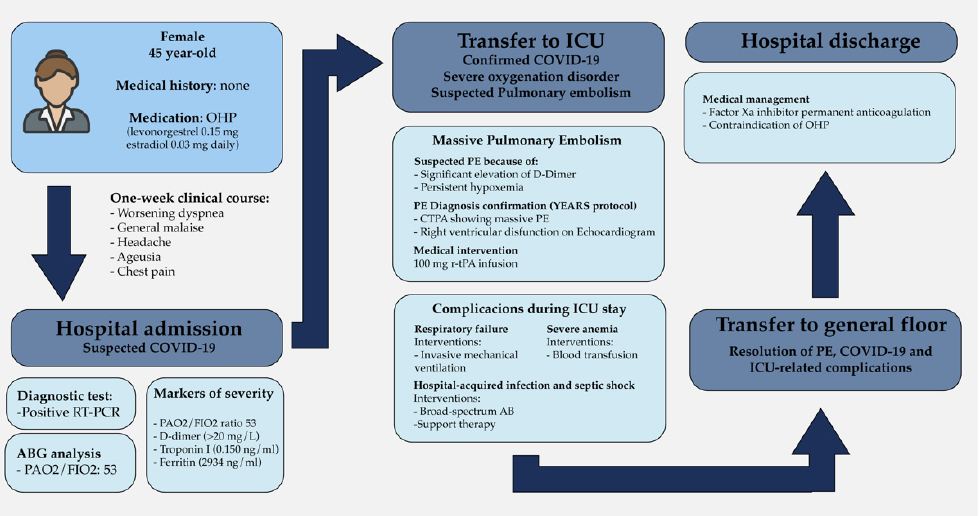
Figure 1. Timeline of events of the clinical case showing laboratory results. Clinical findings and medical decisions. OHP = oral hormonal contraceptives, RT-PCR = retro-transcriptase polymerase chain reaction, ICU = intensive care unit, PE= pulmonary embolism, AB = antibiotics.